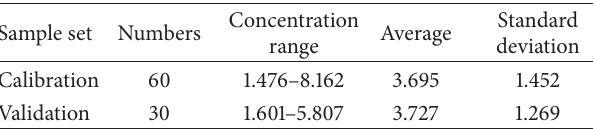
Table 3: Concentration range of SSA in calibration and validation set (mg ⋅ g − 1